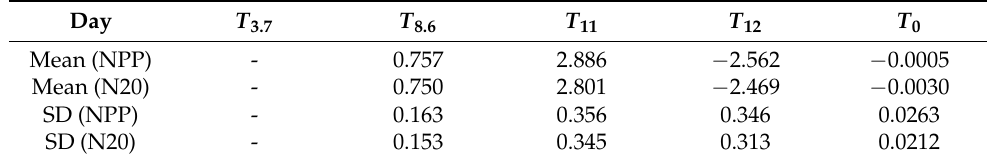
Table 2. Same as in Table 1 but for daytime SSTs produced with Equation (1).